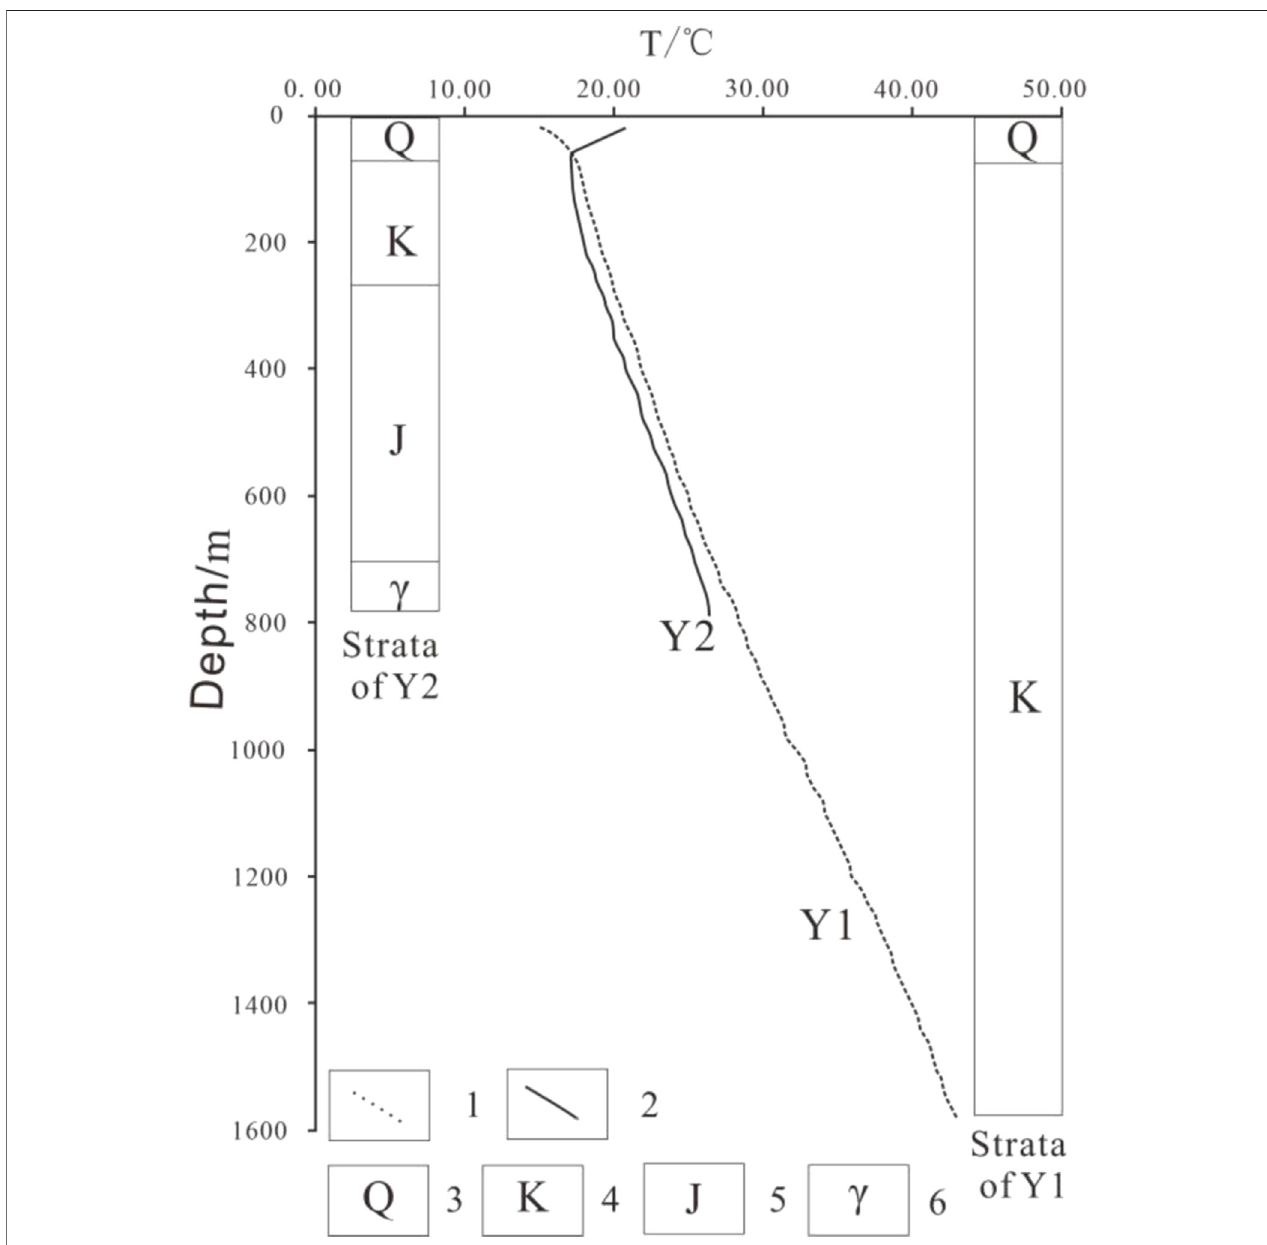
FIGURE 4 | Borehole temperature logs and associated strata in the Yanheying Basin.